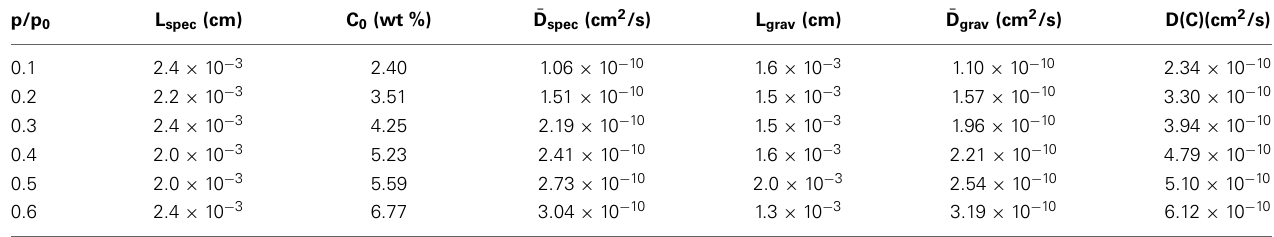
Table 2 | Sample thickness, equilibrium methanol content and diffusivities for the sorption tests performed at different relative pressures of methanol vapor.